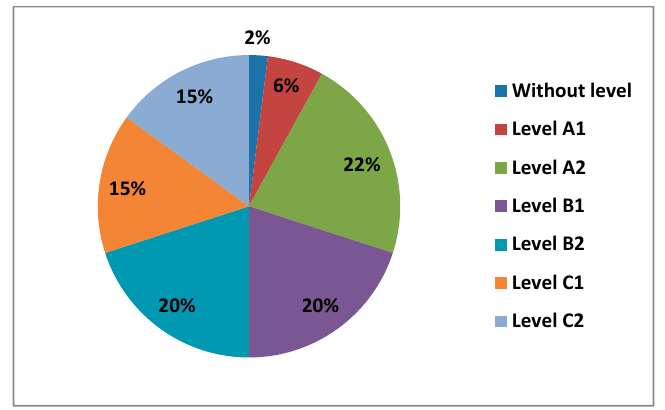
Figure 10. Percentage of teachers by level of digital competence in Area 1.